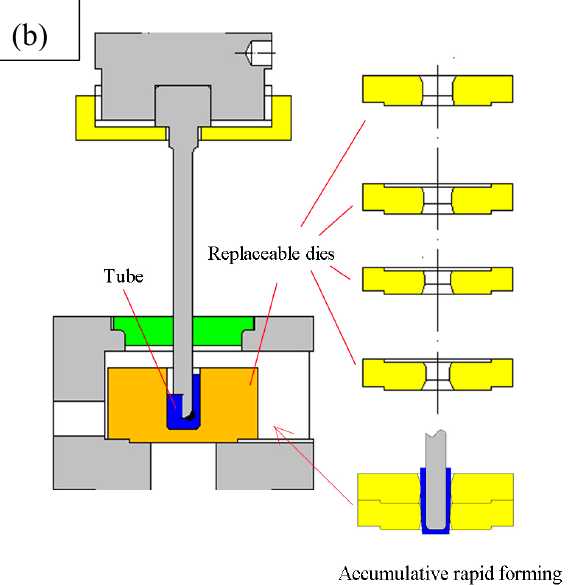
Figure 1. Experiment mold for fabricating thin-walled tubes: ( a ) die parts; ( b ) schematic diagram.